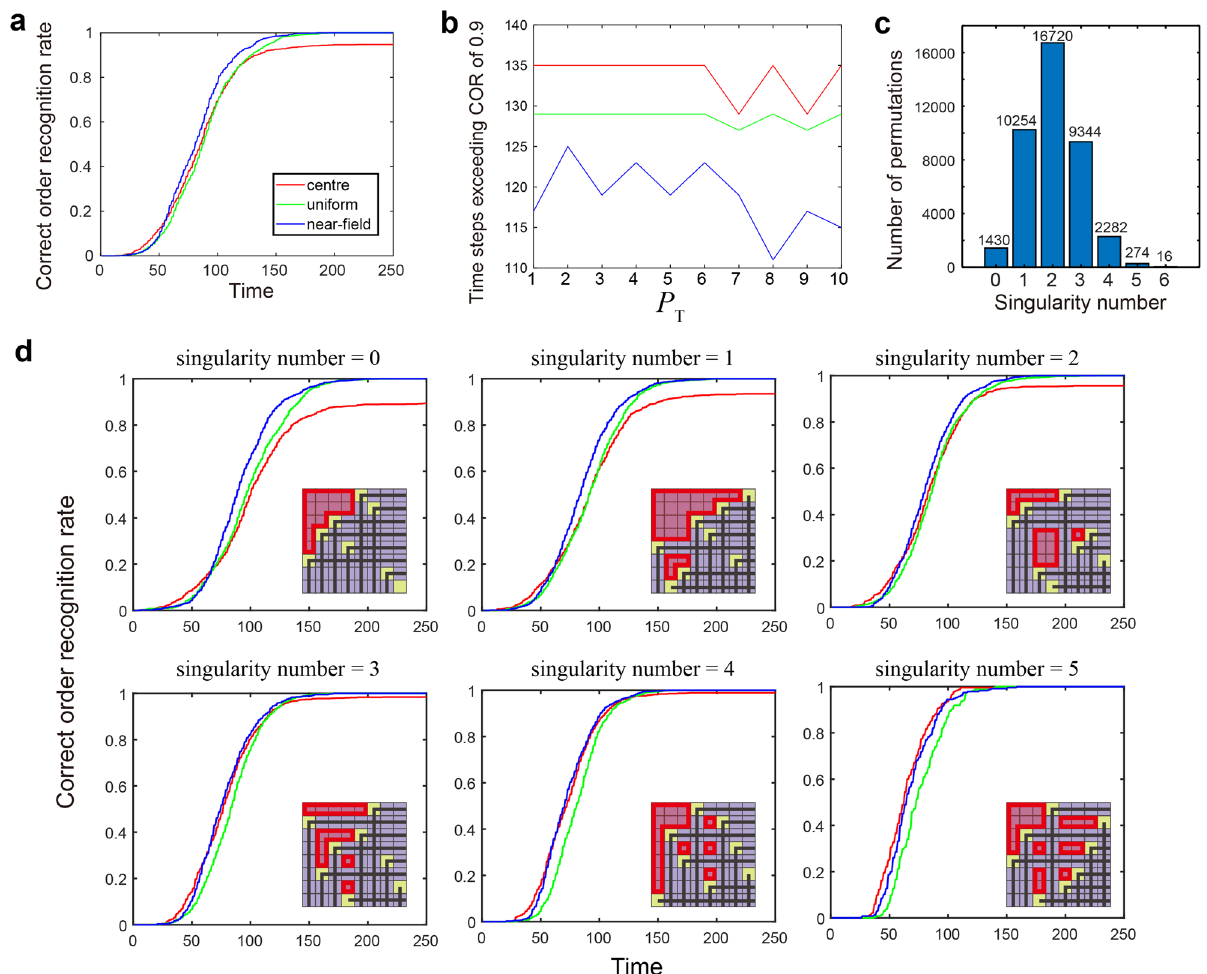
Figure 7. Order recognition performance evaluations with different source randomness using eight slot machine environments. ( a ) Time evolution of the COR rate for the near-field, uniform, and centre patterns. ( b ) The time steps exceed the COR value of 0.9 as a function of the photon number threshold ( P T ). ( c ) The breakdown of all permutations of N = 8 by the number of singularities. ( d ) Comparison of order recognition performances with the problem settings having the same singularity value. When the singularity number is small than 2, the near-field pattern outperforms other sources, whereas, with the largest singularity, the centre pattern exhibits the promptest